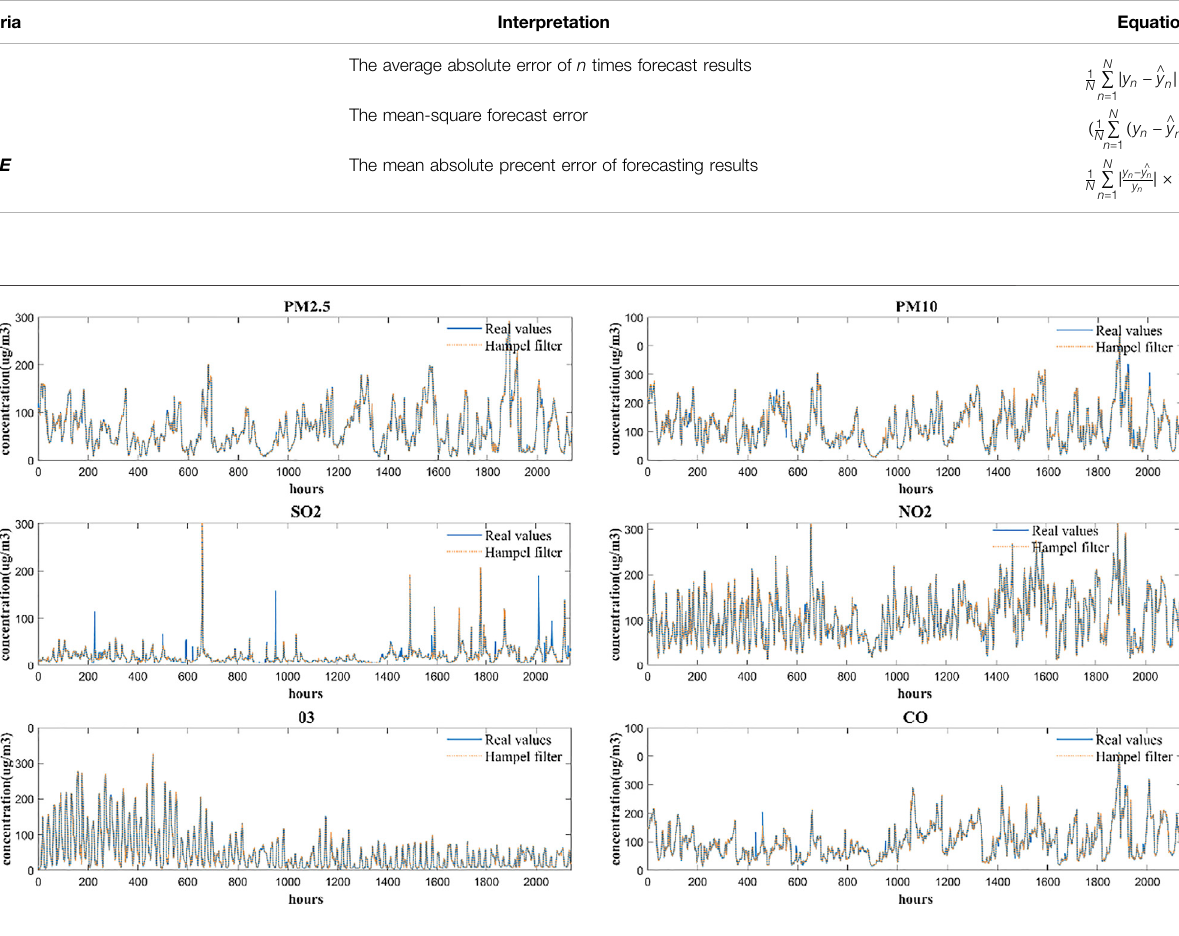
FIGURE 2 | Filtering results of the six pollutants time